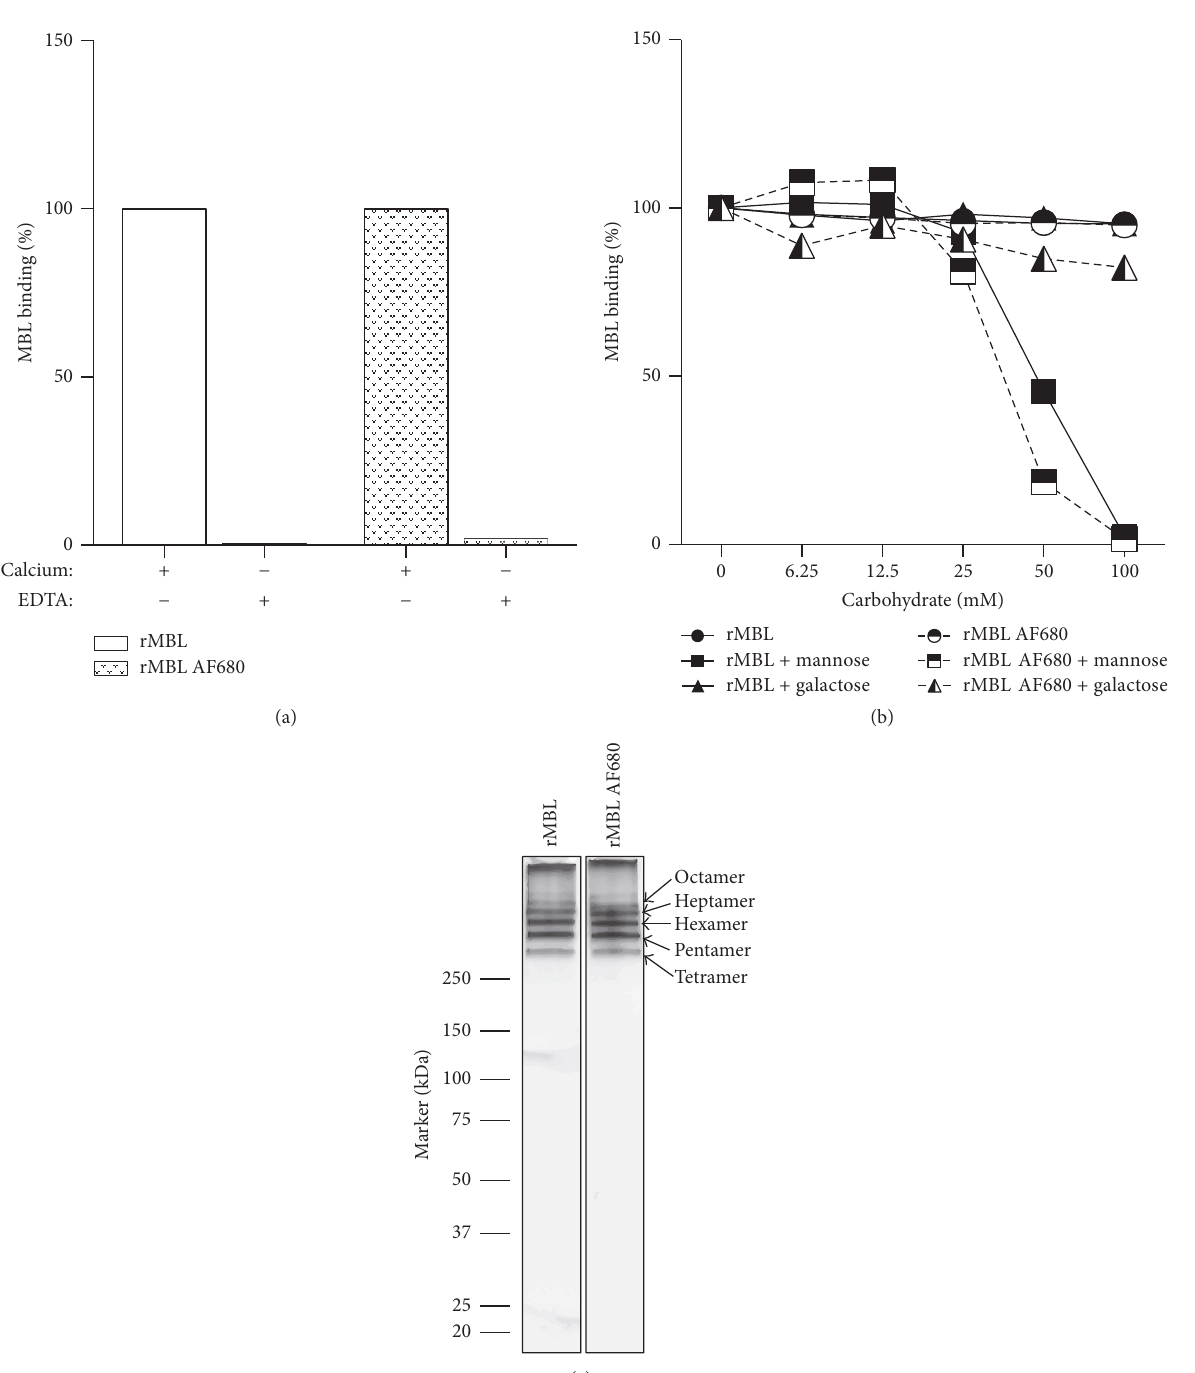
Figure 4: Analysis of retained functionality of AF680 labelled rMBL. (a) rMBL and rMBL labelled with AF680 were analysed for retained binding activity onto a surface of mannan in presence of calcium or EDTA. Values measured in calcium buffer were defined as 100% and subsequent samples were calculated according to these. (b) AF680 labelled rMBL and unlabelled rMBL were analysed for binding activity in the presence of mannose or galactose. Values obtained in the presence of galactose were defined as 100% and subsequent samples were calculated according to these. (c) SDS-PAGE followed by silver staining of rMBL and rMBL AF680 with arrows indicating the distribution of rMBL oligomers. Molecular marker is given in kDa. All values are given in percentage (%) of bound rMBL with values obtained in the presence of galactose defined as 100% bound and subsequent samples calculated according to these. The experiments were repeated twice with similar